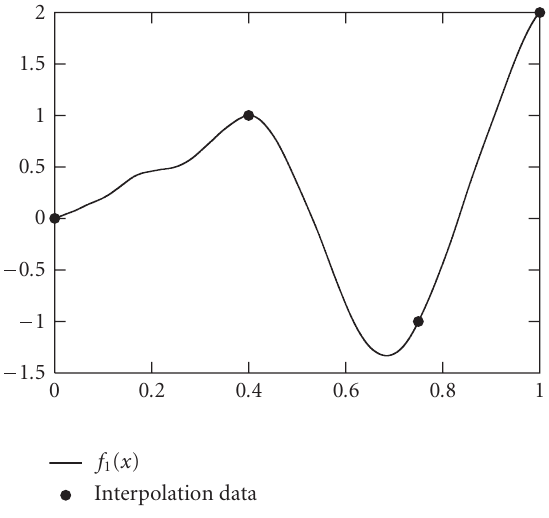
Figure 5.7. E ff ect on spline CHFIF by a change in the boundary conditions of f 2 ( x ).